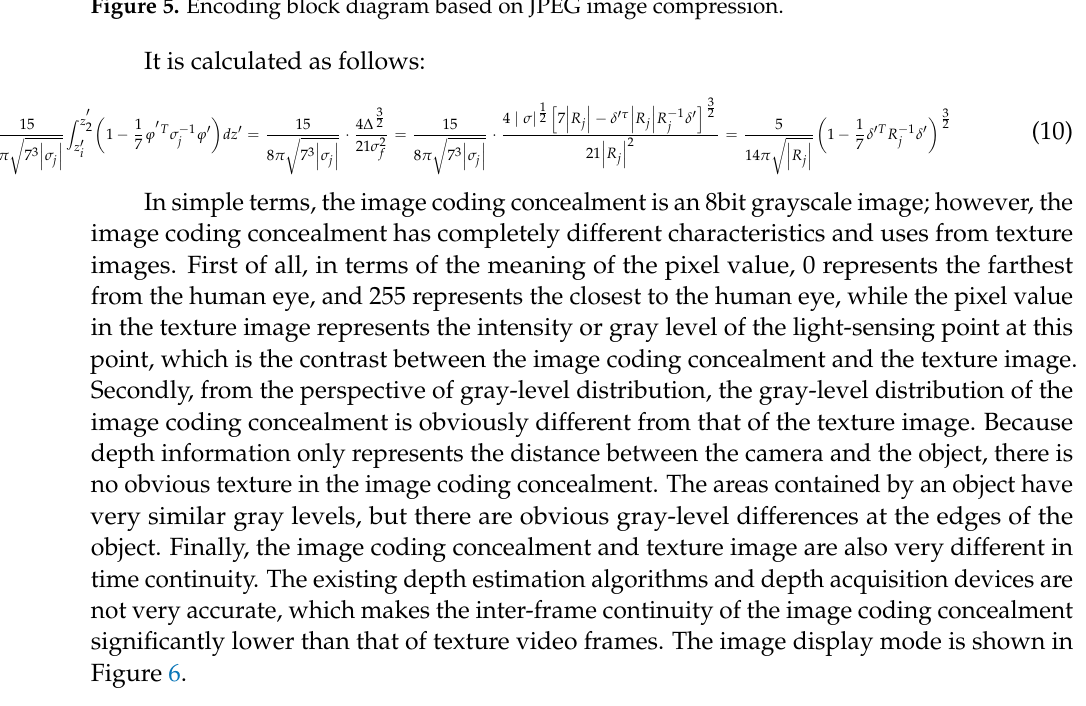
Figure 5. Encoding block diagram based on JPEG image compression.